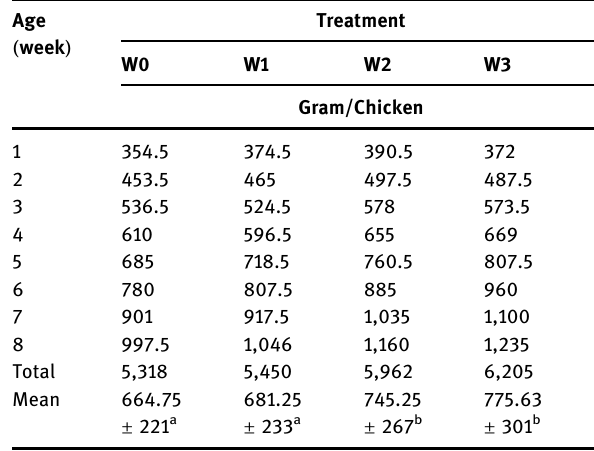
Table 3. : Body weight gain means during 8 weeks of